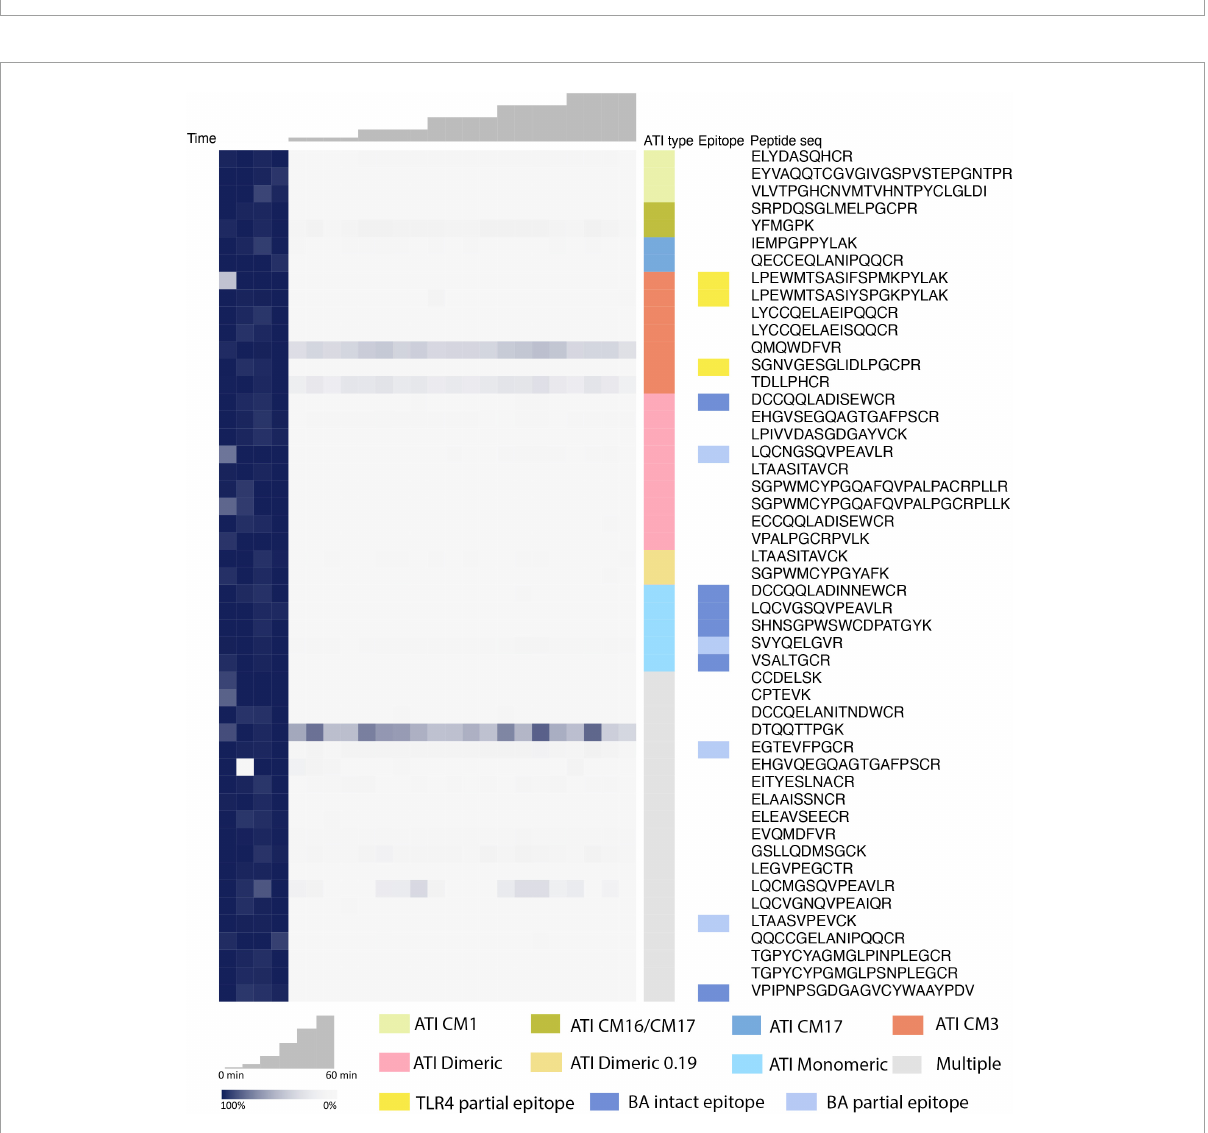
FIGURE2 Overall trends of ATI peptide digestibility in Baxter. Peptide peak area values of all peptides included in the analysis are presented in the individual replicates and monitored during the digestion analysis. Majority of the peptides were more than 95% reduced within 5 min of digestion, including those present in one or more subtypes of ATIs that are